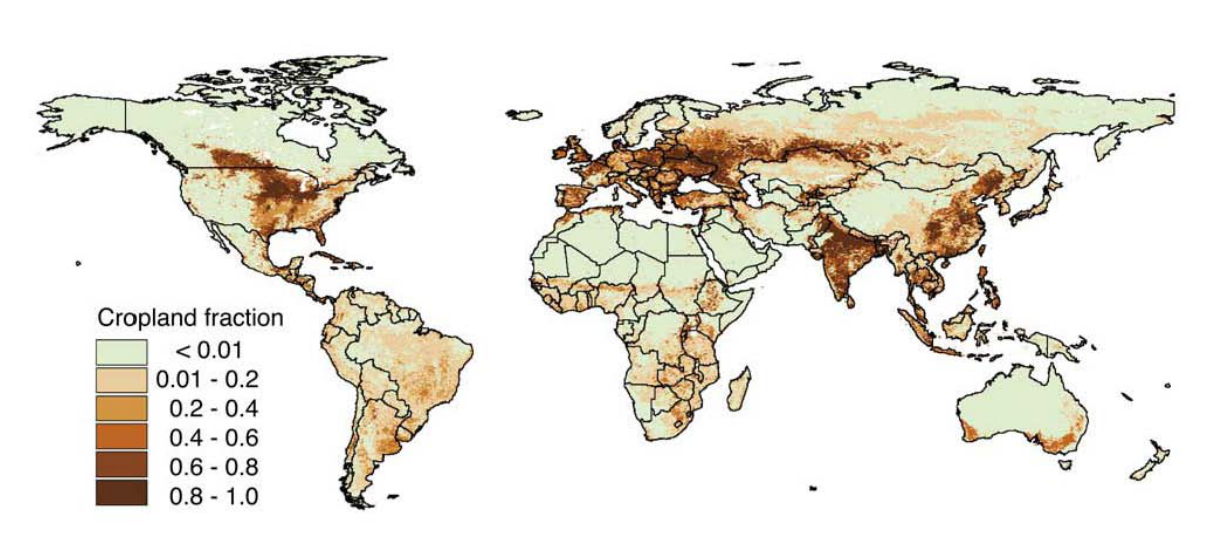
Figure 2. Global cropland map by Ramankutty et al . [40] and Ramankutty and Foley [48]. This includes irrigated and rainfed areas of the world as well as permanent crops. Total area of croplands is 1.47 billion hectares. The product is derived using national agricultural census data and remote sensing derived land use. The output is given in nominal 5-min (0.083333 decimal degrees)